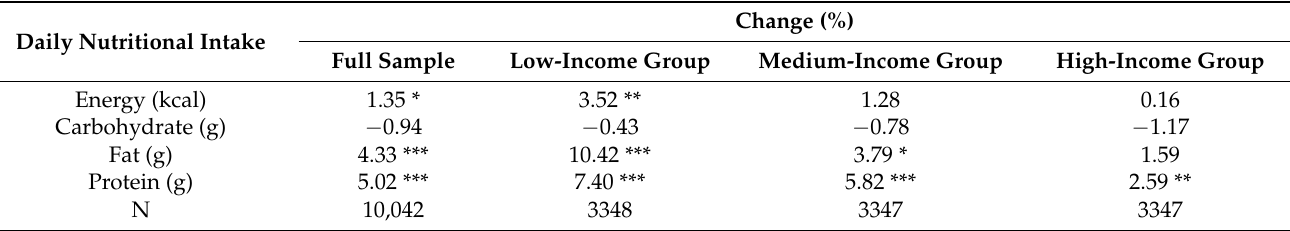
Table 4. Effects of internet access on nutritional intake for different income